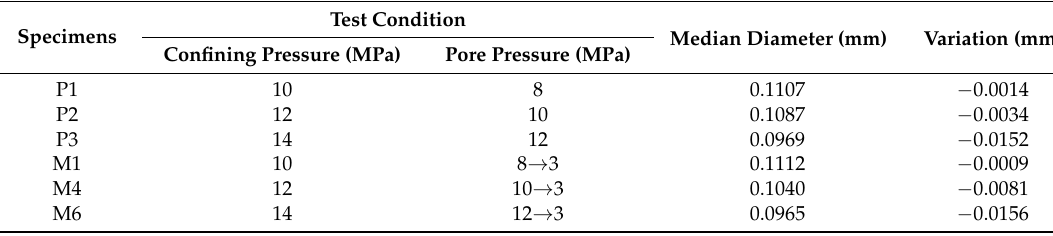
Table 2. Median size of the specimens after the shear